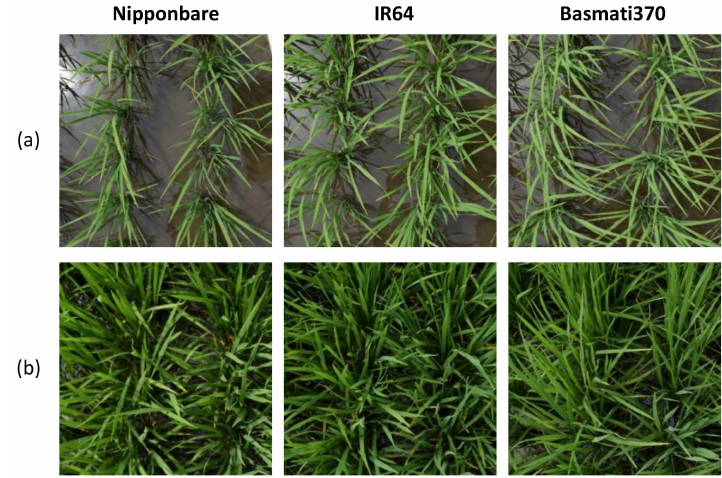
Figure 2. Examples of photos of 8 hills of 3 cultivars (Nipponbare, IR64 and Basmati370) with medium fertilization in replication 2 taken on ( a ) 3 July and ( b ) 27 July in 2018.